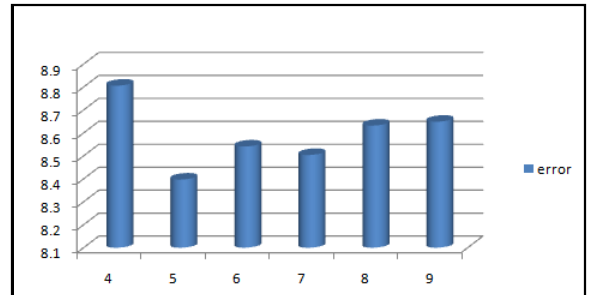
Figure 3. RTK GPS Iskandar Network (2 Minutes)